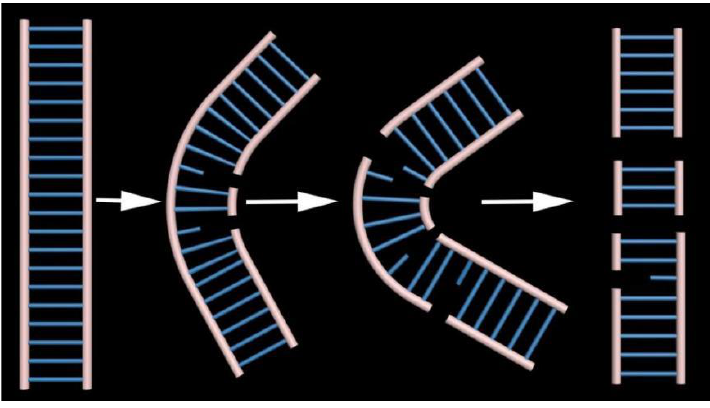
Figure 7. Damage process of PN to DNA.